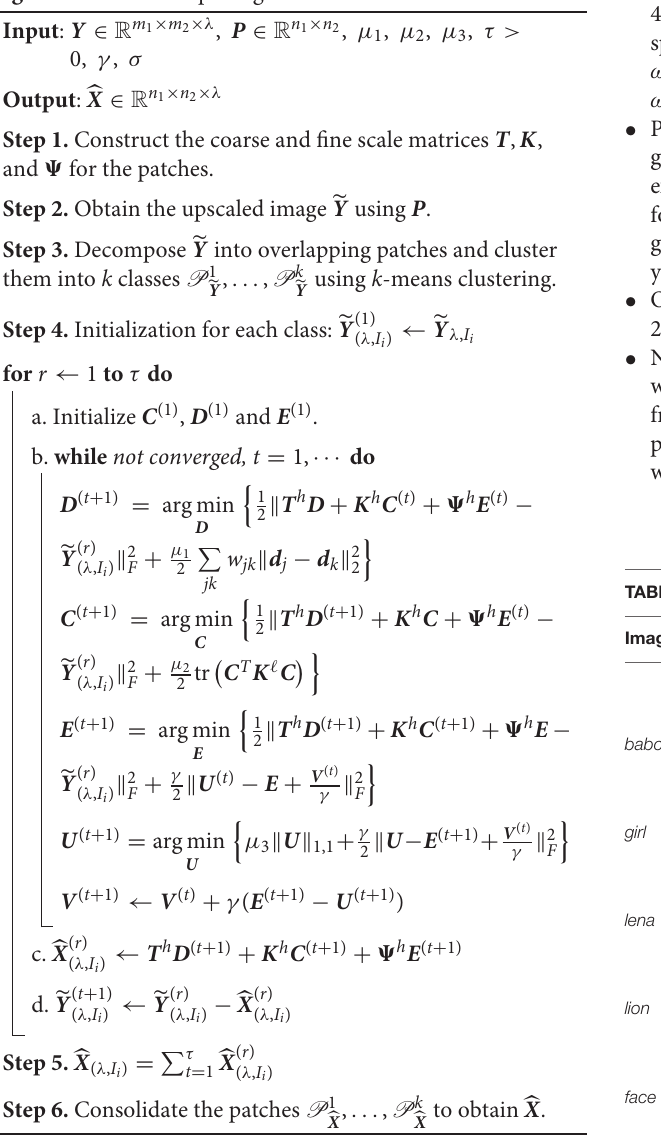
Algorithm 2: Pansharpening model